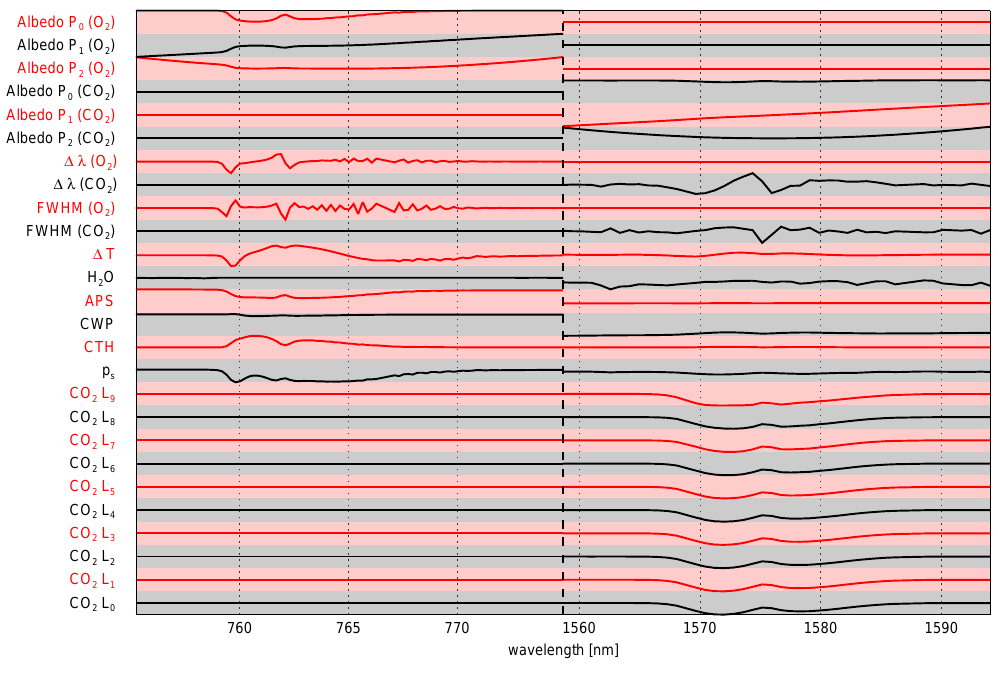
Fig. 4. Weighting functions (scaled to the same amplitude) calculated with the SCIATRAN 3.0 radiative transfer code for the first guess state vector of the “met. 1 σ ” scenario at 40 ◦ solar zenith